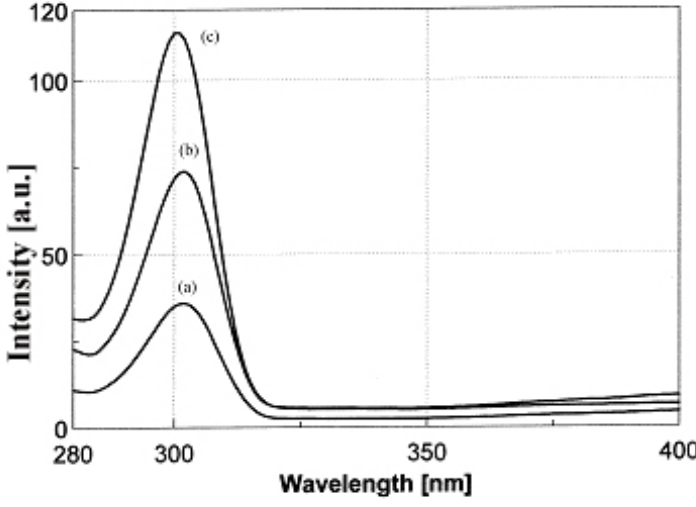
O) ](SO ) O  2H 2 2 4 0.5 2